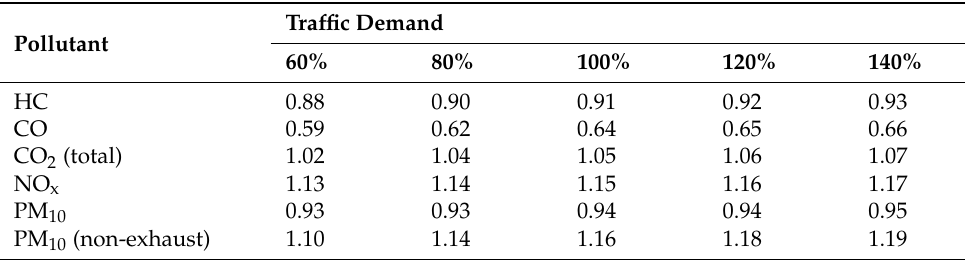
Table 5. Change in the emissions per km (i.e., link based using “URB/Trunk-City/50/” as a street type vs. link based with the correct street